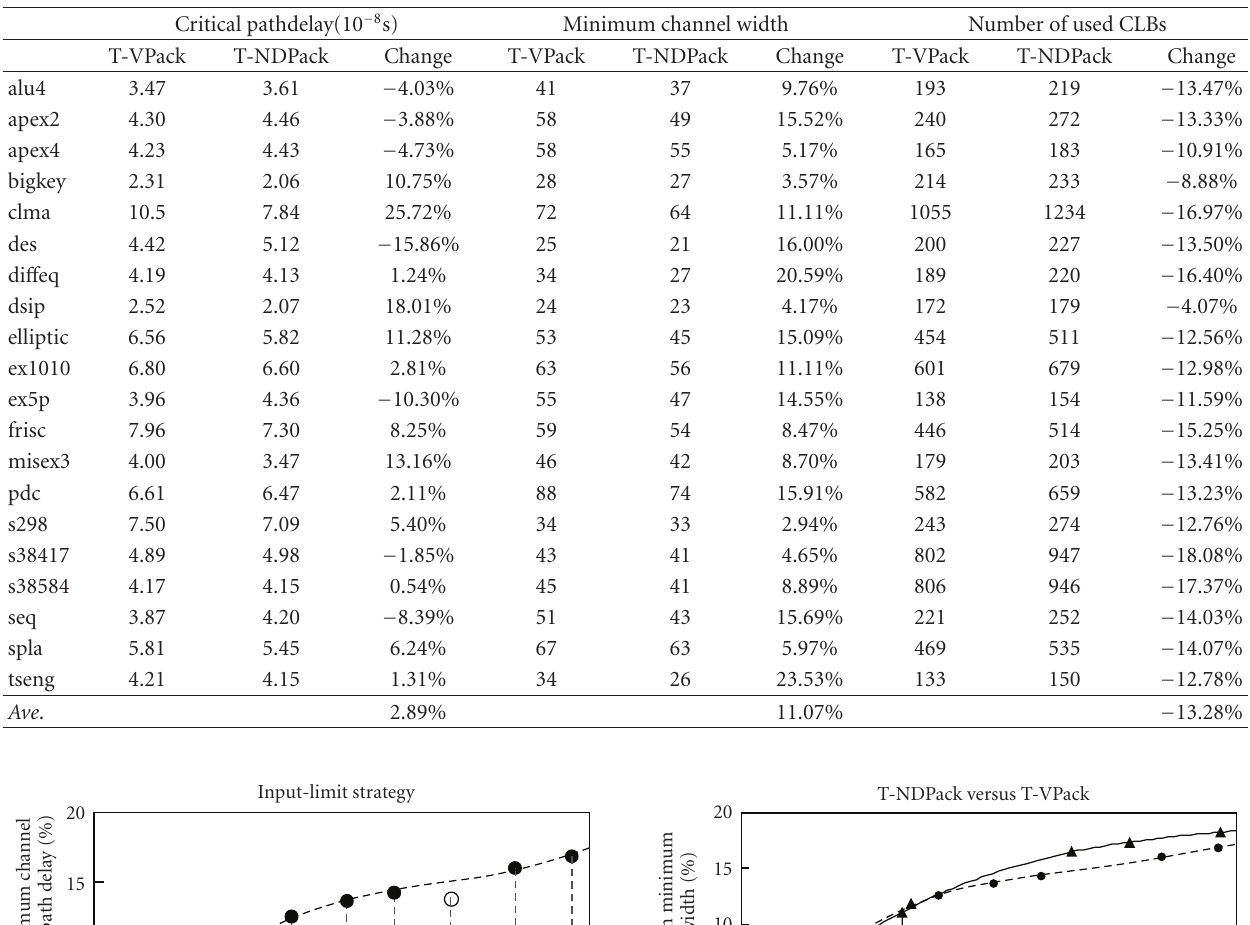
Table 9: Comparison between T-NDPack and T-VPack on the critical path delay, minimum channel width, and number of used CLBs metrics over 20 MCNC benchmark circuits (positive percentage means improvement).